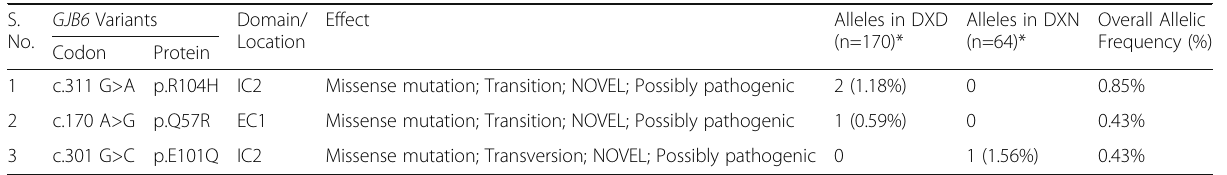
Table 7 Novel GJB6 variants observed in DXD and DXN